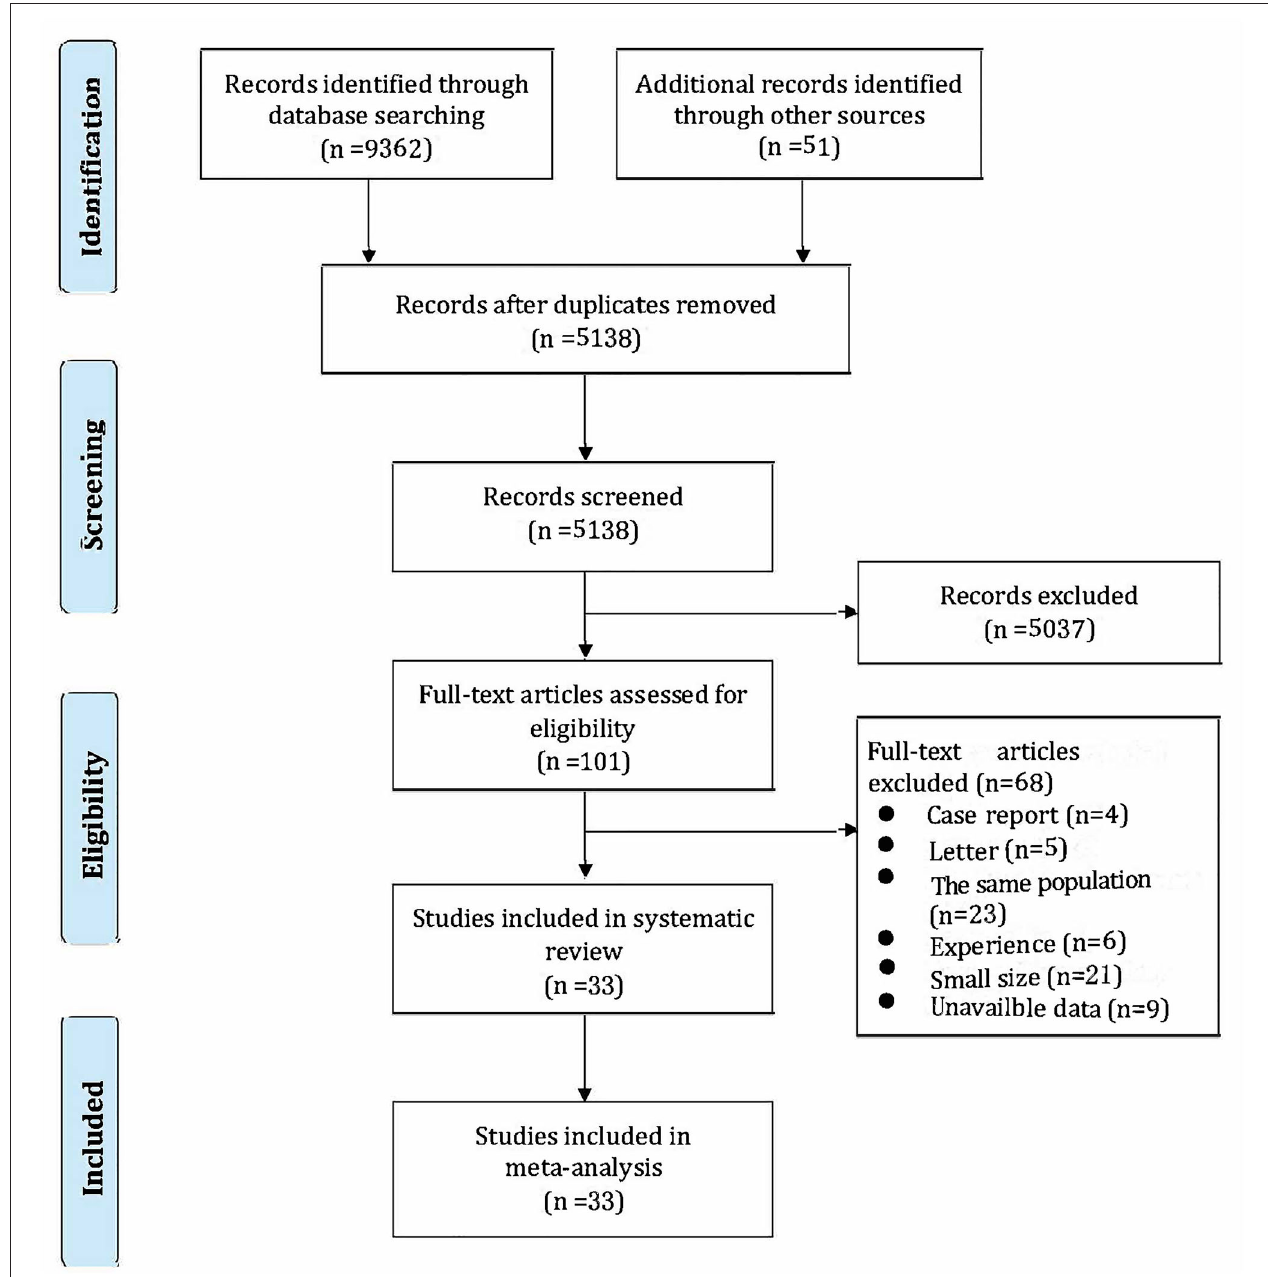
FIGURE 1 | Study selection process and results.